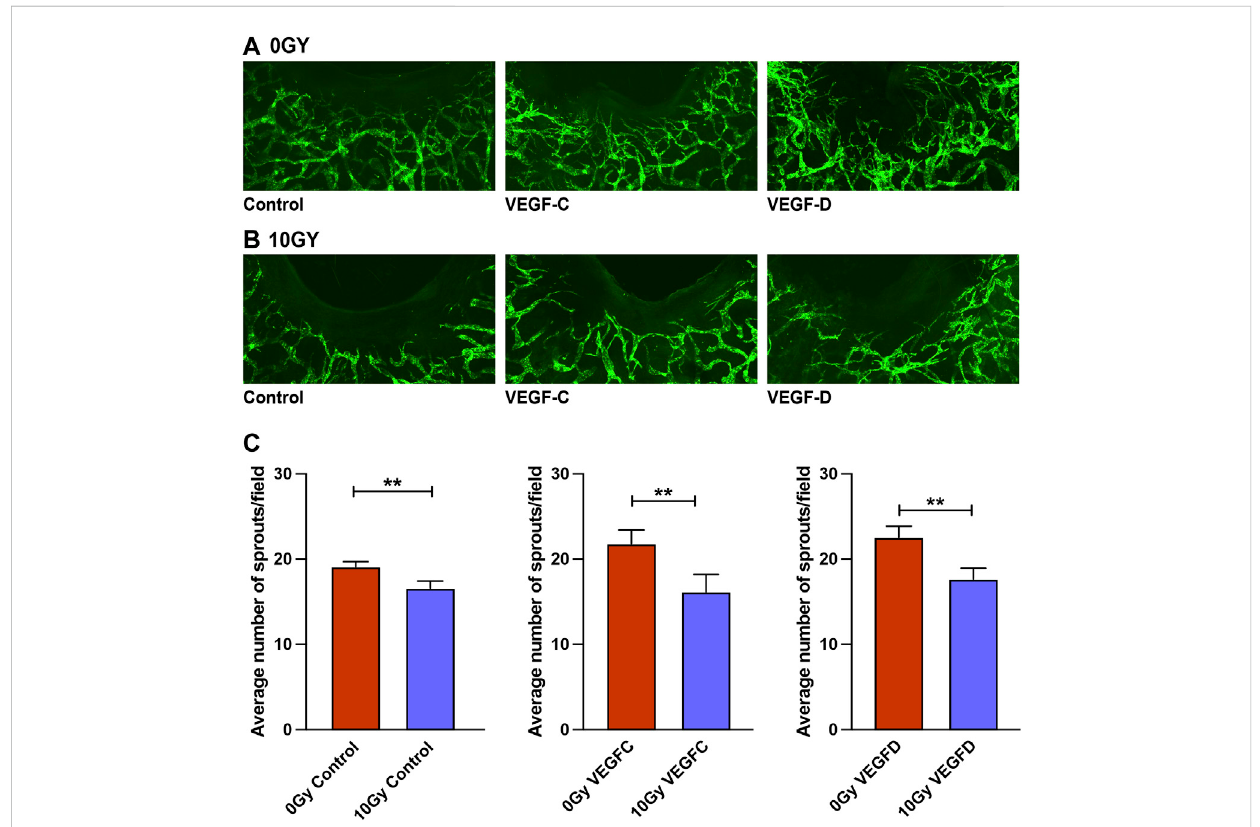
TreatmentwithVEGF-CandVEGF-DproteindoesnotsalvagelymphangiogenicimpairmentinProx-1/GFPmouseearwounds. (A) Prox-1/GFPmice ear wounding model in unirradiated ears with control (vehicle), 1 μ g VEGF-C and 1 μ g VEGF-D treatment showing a therapeutic lymphangiogenic response to these traditional growth factors. (B) Prox-1/GFPmouse ear wounding model inirradiated counterpart earswith control (vehicle), 1 μ g VEGF- C and 1 μ g VEGF-D treatment showing an ameliorated lymphangiogenic response to these traditional growth factors. (C) Quanti fi cation of lymphatic sprouting at the wound edge demonstrating differences between0 Gy and 10 Gy wounded ears in response to vehicle, 1 μ g VEGF-C and 1 μ g VEGF-Dtreatments.Eachgroupisrepresentedby n =6,withblindedquanti fi cationcompletedbytwoindividualsindependently.Dataexpressedasmean with error bars represented as SEM, * p < 0.05; *** p <